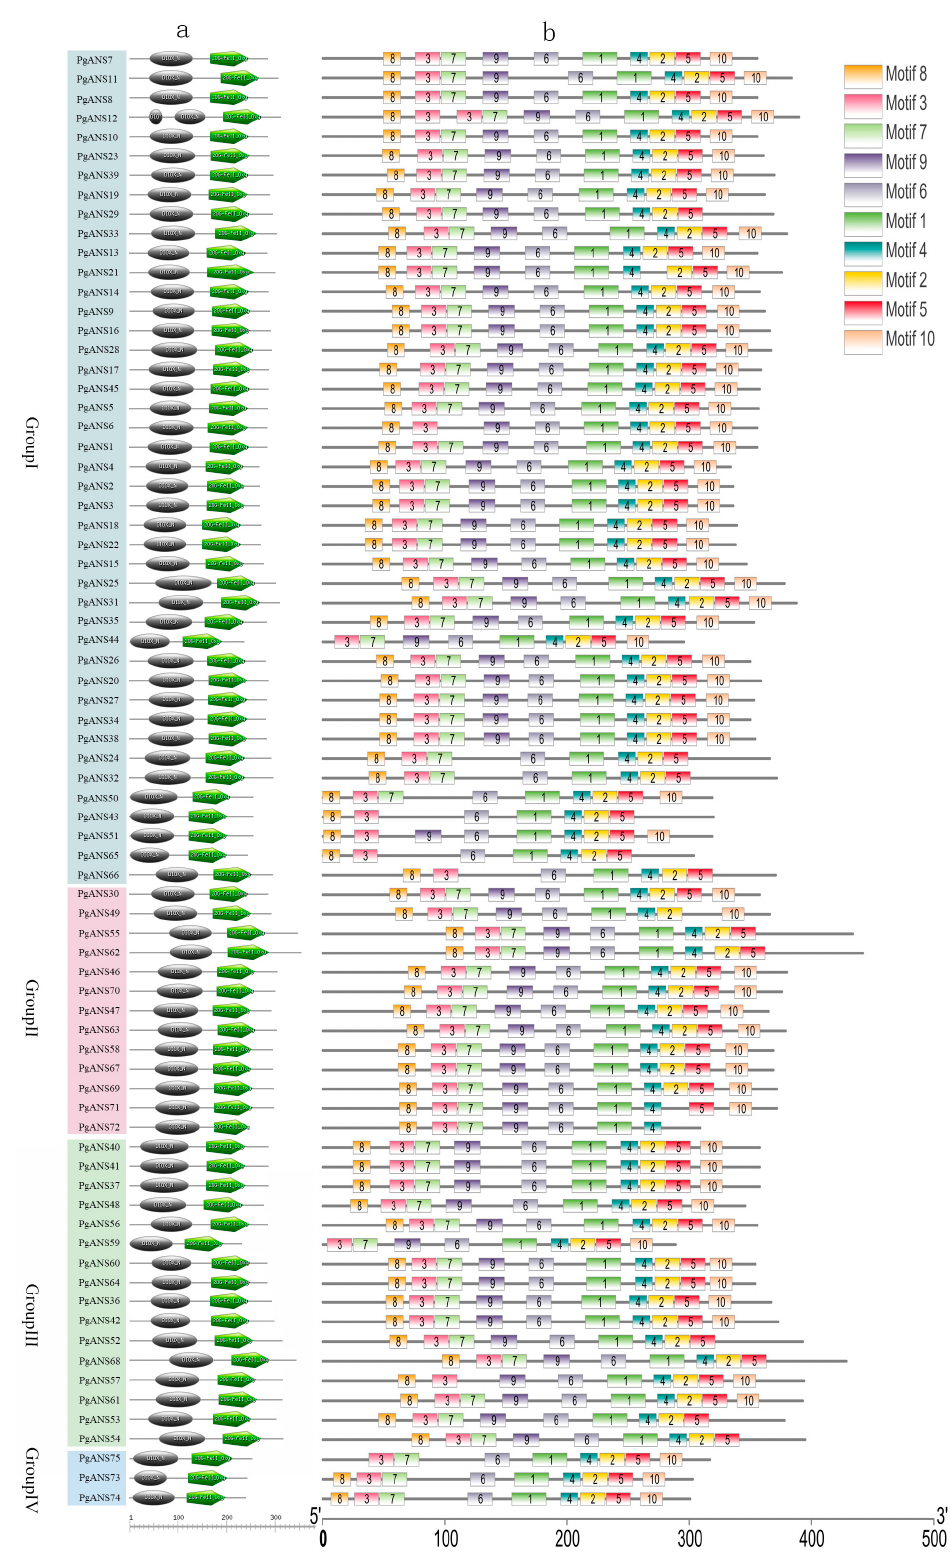
Figure 2. Conserved structural domains of the pomegranate ANS proteins ( a ) and conserved motifs of the pomegranate ANS proteins ( b ).